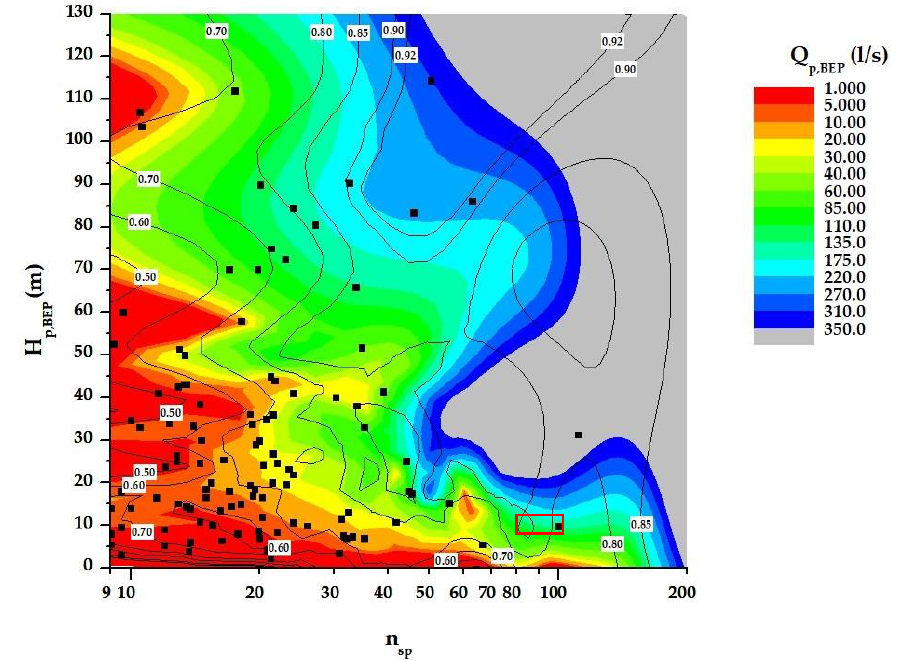
Figure 4. PATs classified according to 𝑛 𝑠𝑝 (m, kw).